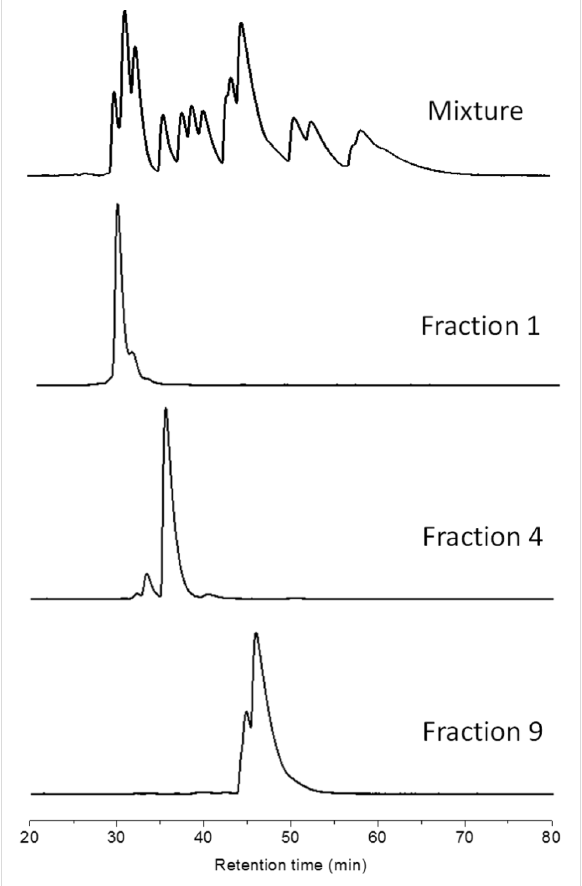
Figure 3: Chromatograms of IC 70 BA mixture and fractions 1, 4 and 9 separated by HPLC (Cosmosil Buckyprep-D column, toluene, 0.2 mL/min). Note that fraction 9 was further separated by flash chro- matography (silica gel, toluene/cyclohexane 1:9) into fractions 9-1 and